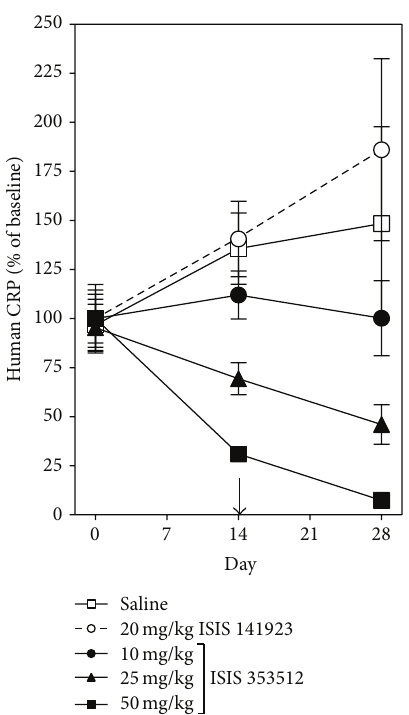
Figure 4: ASO-mediated lowering of human CRP in CRPtg mice subjected to RCCA ligation. Serum human CRP values were determined by ELISA for rats injected i.p. with (i) the CRP targeting ASO ISIS 353512 (10mg/kg/wk, 𝑛 = 9 ; 25 mg/kg/wk, 𝑛 = 30 ; 50 mg/kg/wk, 𝑛 = 5 ), (ii) the control ASO ISIS 141923 (20 mg/kg/wk, 𝑛 = 12 ), or (iii) an equivalent volume of 0.9% saline (𝑛 = 13) . The arrow indicates the day RCCA ligation surgery was